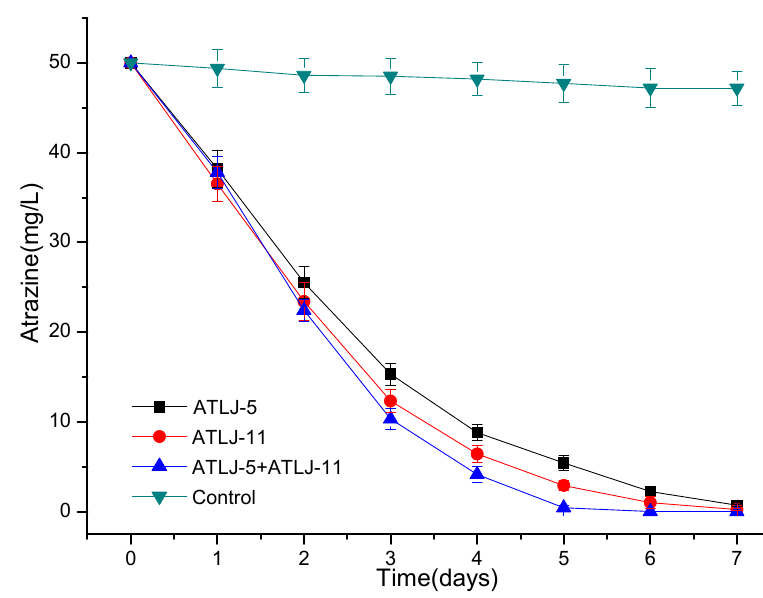
Figure 5. The curve of the degradation of atrazine by different microorganisms.